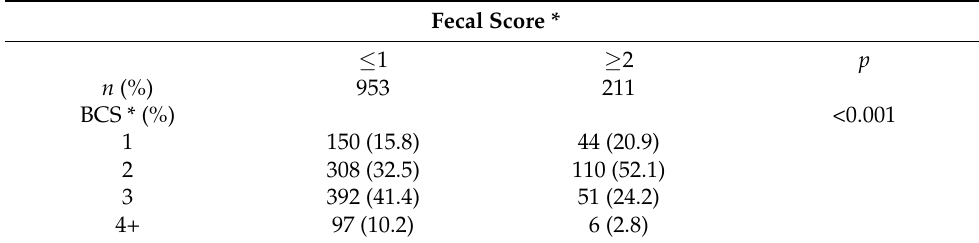
Table 5. Fecal score and body condition